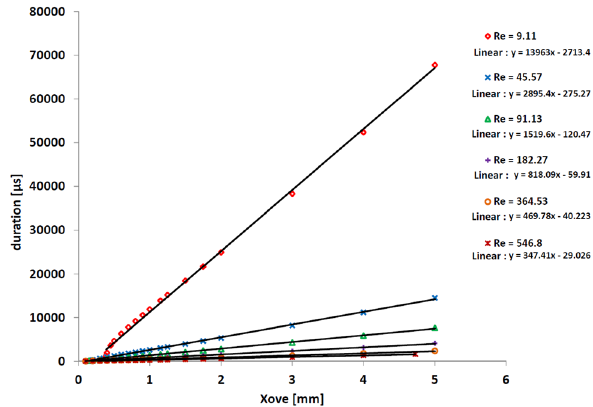
Fig. 10 Cavitation duration with respect to X of the Reynolds number H